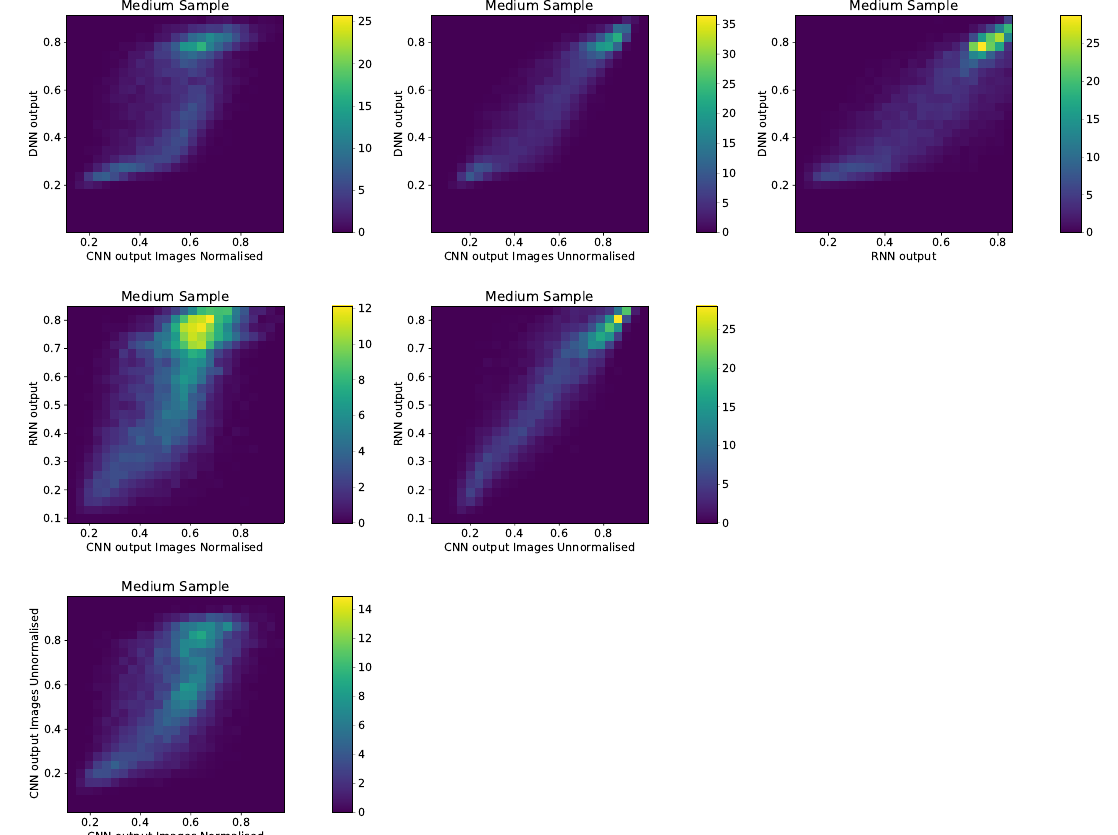
Figure 17 . Bi-dimensional distributions of the Deep Neural Network outputs for the Medium